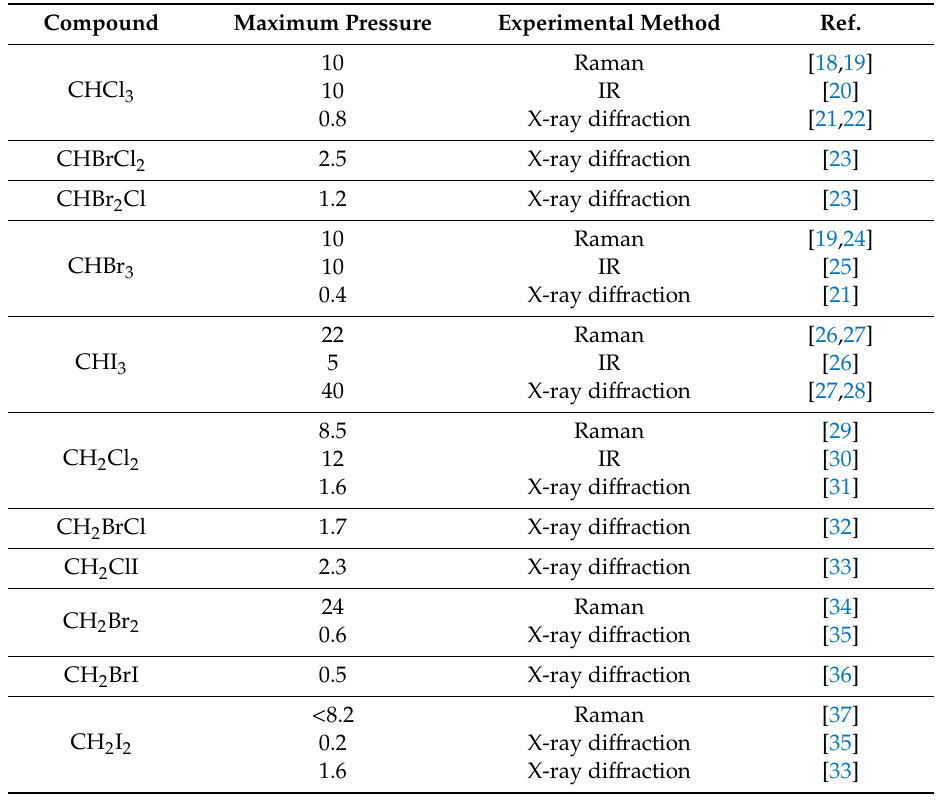
Table 1. Summary of high-pressure experimental studies on tri- and dihalomethane molecules. Pressure is given in GPa and Raman / IR refers to Raman scattering / IR absorption